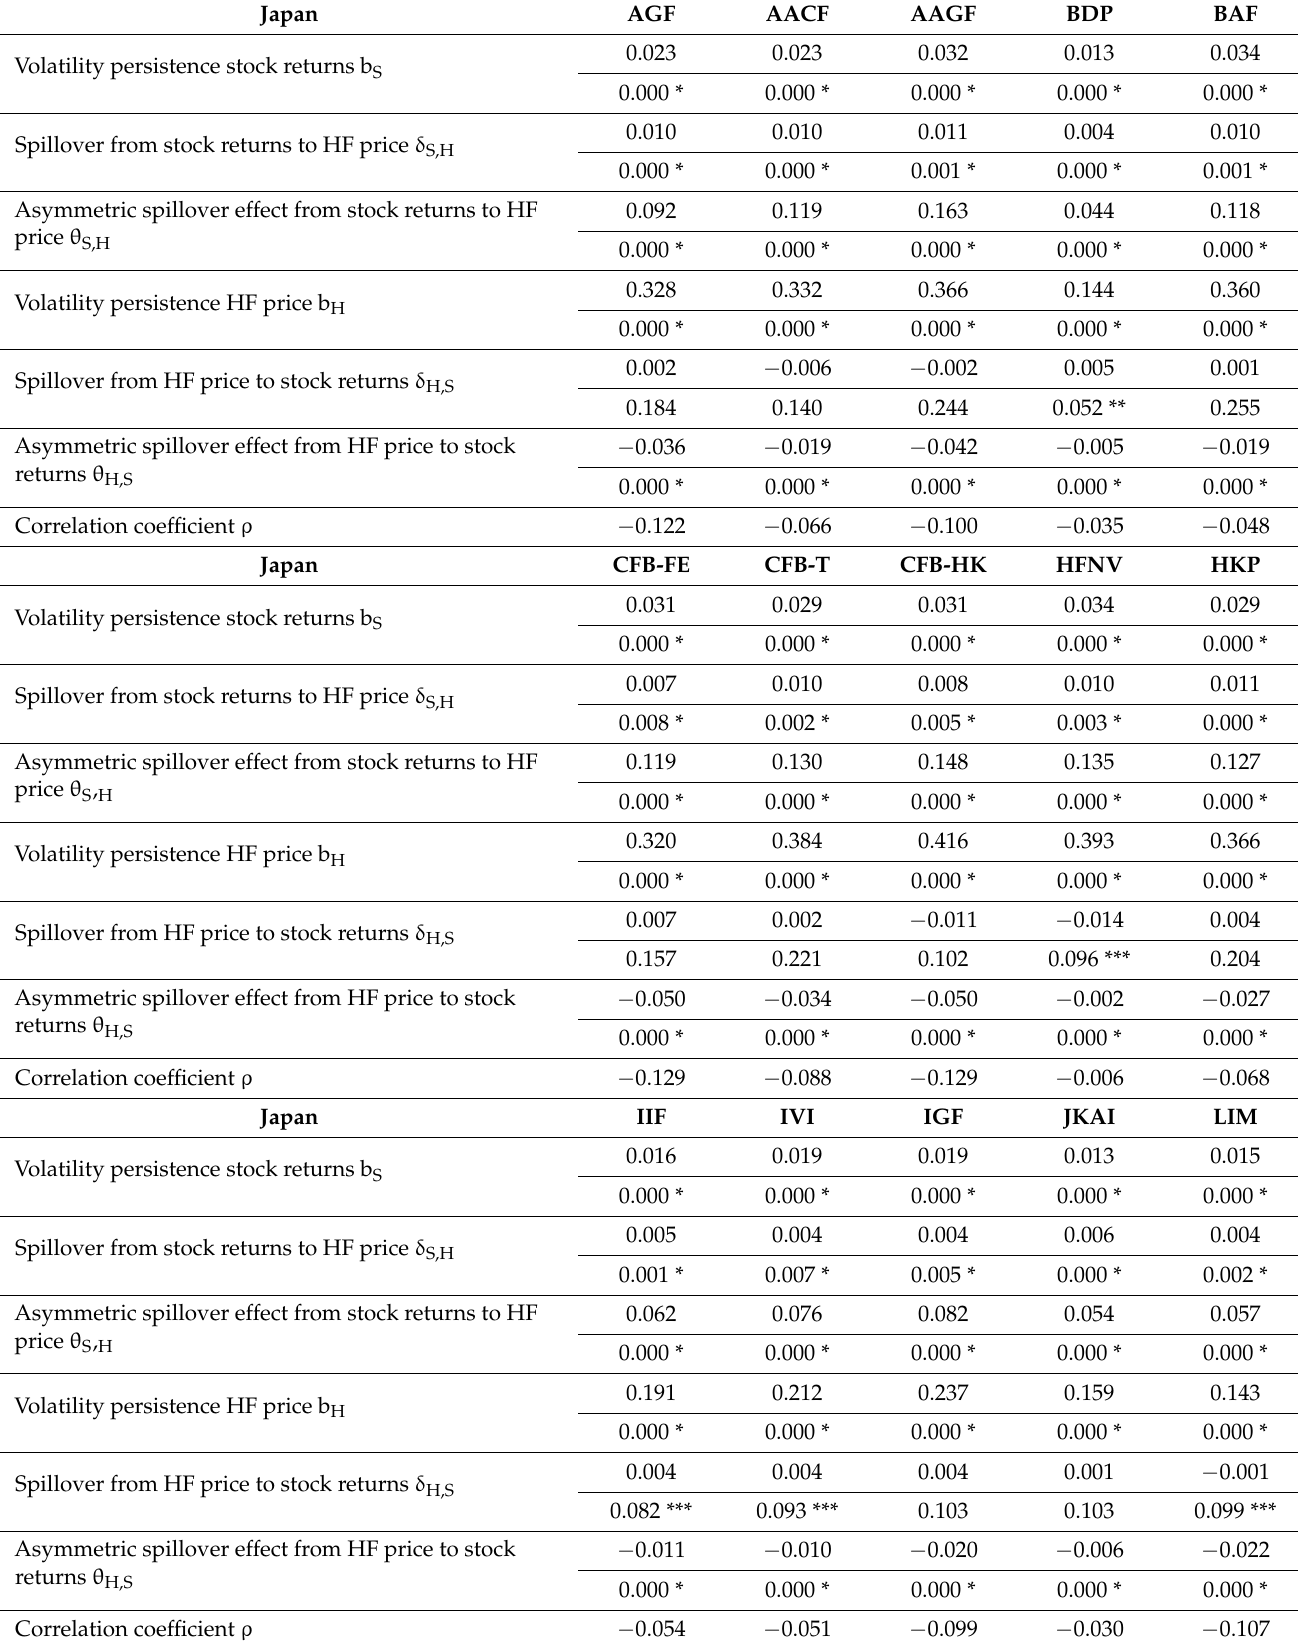
Table 4. The Volatility spillover between the Japanese Stock Market (JPY) and Hedge Fund